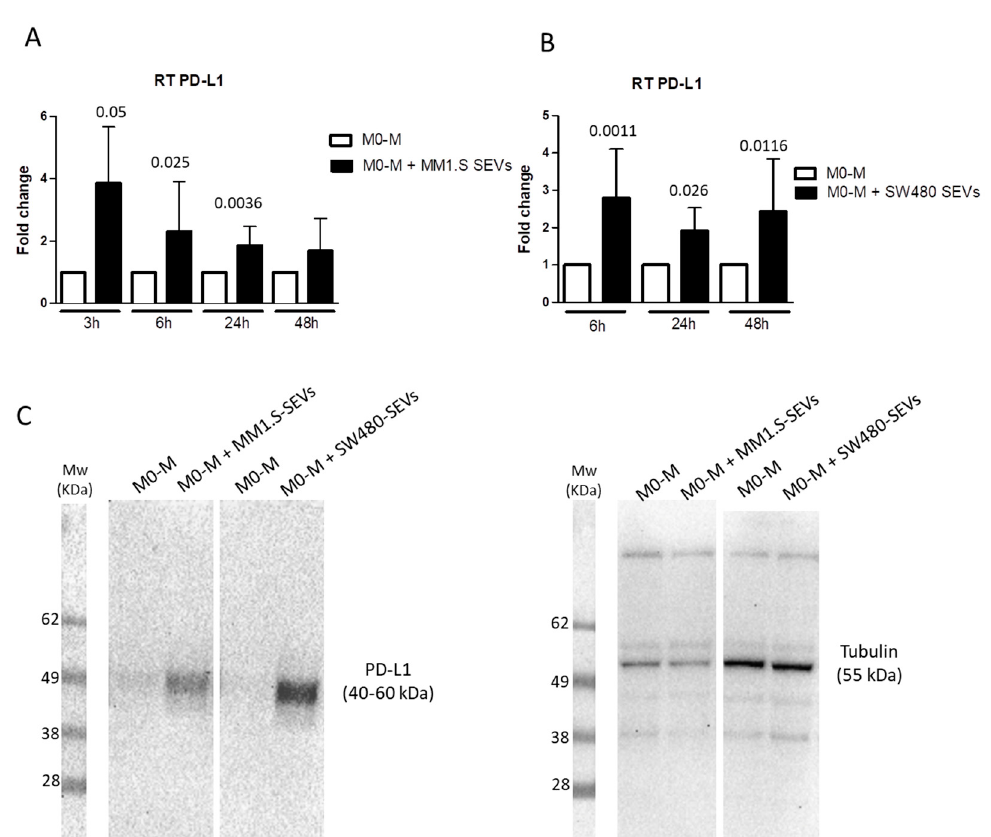
Figure 2. ( A ) RT PCR of PD-L1 mRNA levels in M0-M treated with MM1.S-SEVs for 3, 6, 24, and 48 h. ( B ) RT PCR of PD-L1 mRNA levels in M0-M treated with SW480-SEVs for 6, 24, and 48 h. The reported values are the mean ± standard deviation of three replicates at least. The statistical significance of the differences between the SEV-treated cells and the control for each time point was analyzed using a two-tailed Student’s t -test. ( C ) Western Blot analysis of PD-L1 and tubulin proteins in M0-M treated with MM1.S- and SW480-SEVs for 24 h.